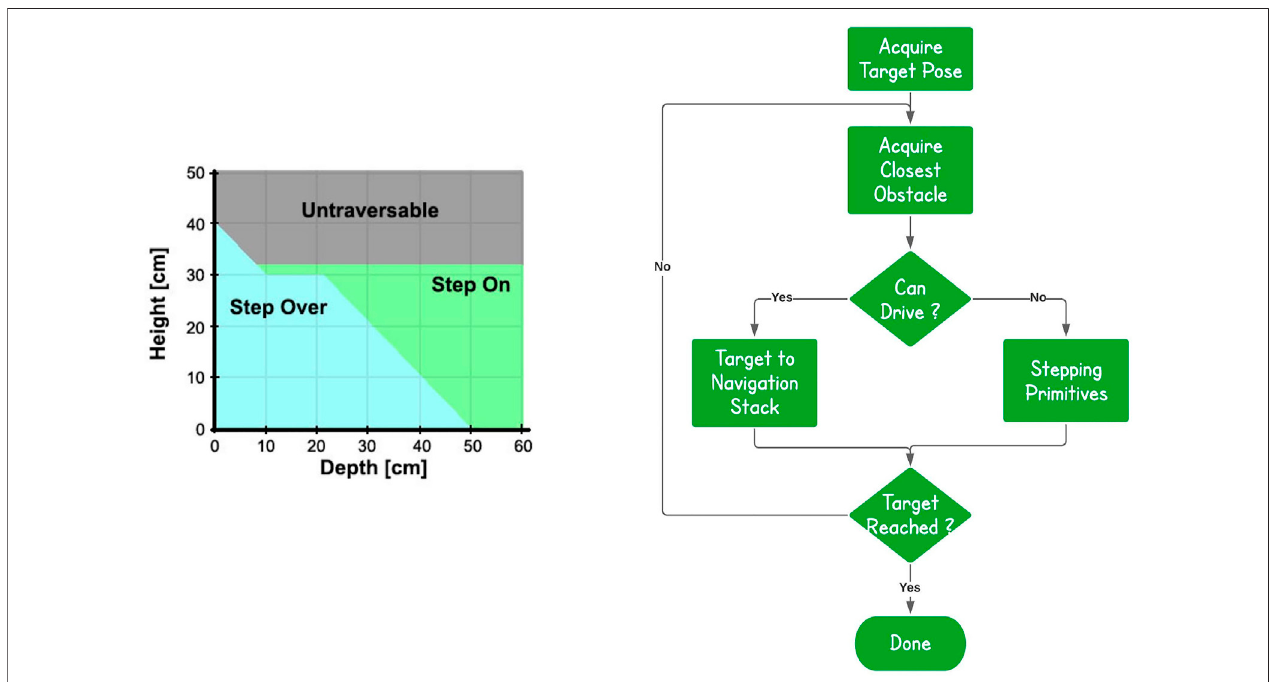
FIGURE5| Primitive-basedReasoning.Foreachobstaclethattherobotfaces,wecheckifwecandrivearoundit.Ifthisisnotpossiblethehybridplannerisusedto derive appropriate traversing actions using the StepOn , StepDown and StepOver primitives .